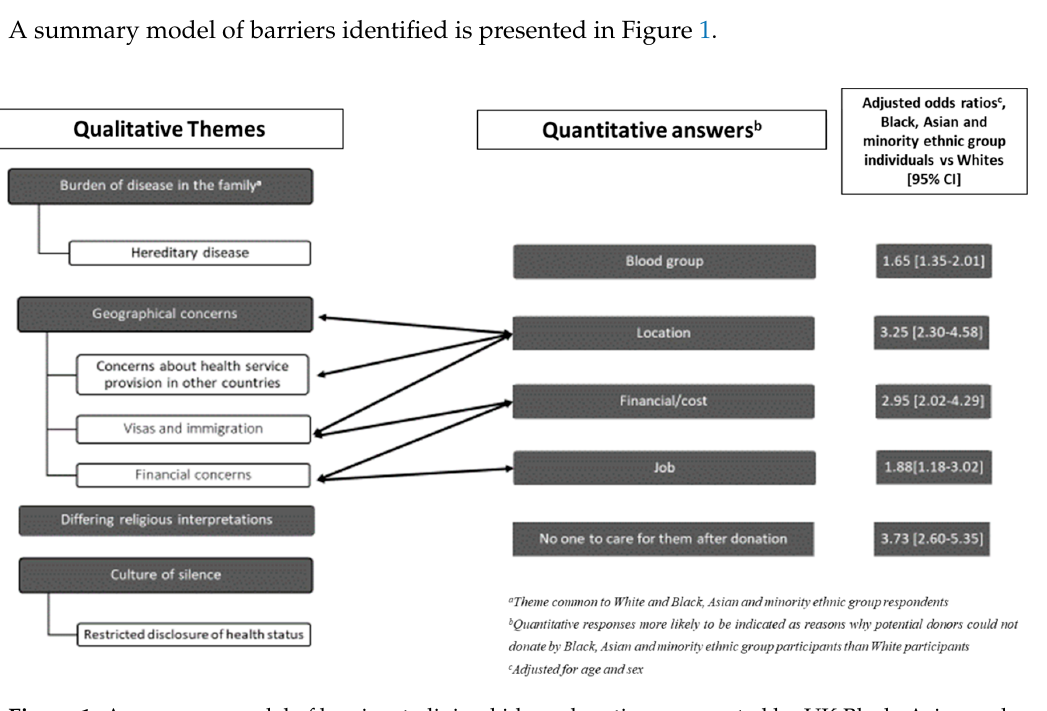
Figure 1. A summary model of barriers to living kidney donation as reported by UK Black, Asian and Minority Ethnic individuals.